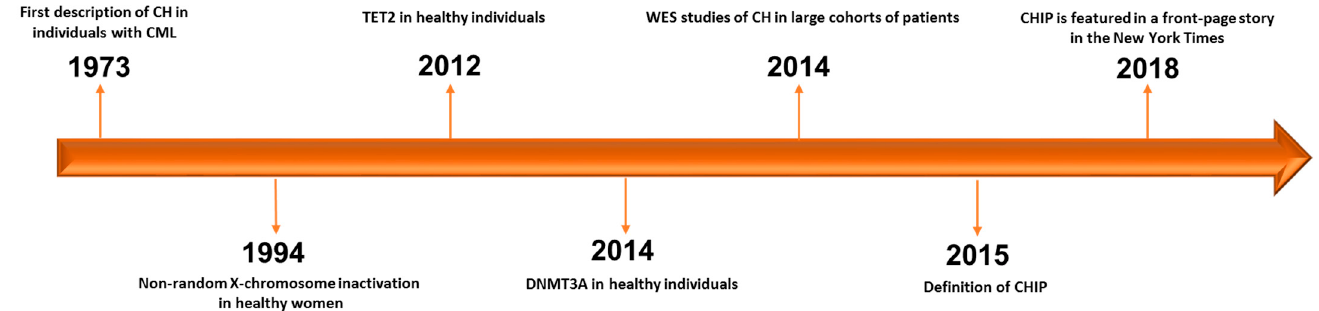
Figure 1. Timeline of progress towards discovery and definition of CHIP. CH: clonal hematopoiesis. CML: chronic myelogenous leukemia. WES: whole-exome sequencing. CHIP: clonal hematopoiesis of indeterminate potential [11–14,16– 19].